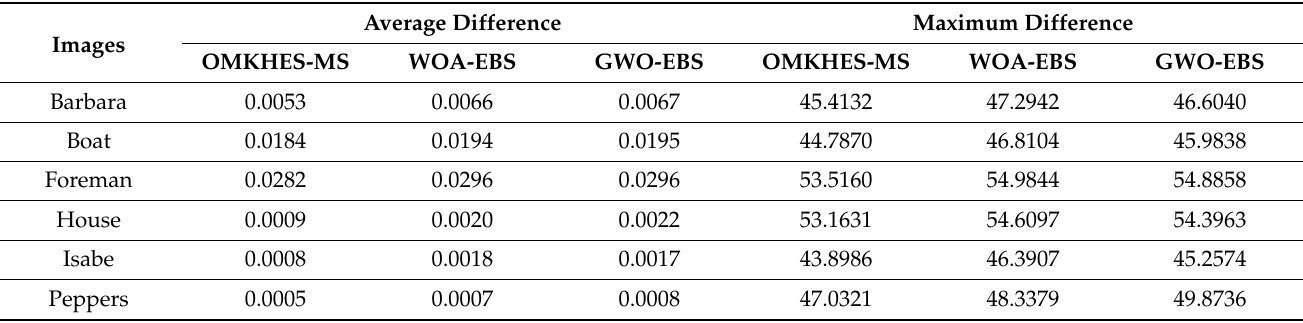
Table 3. AD and MD analysis of OMKHES-MS technique with different